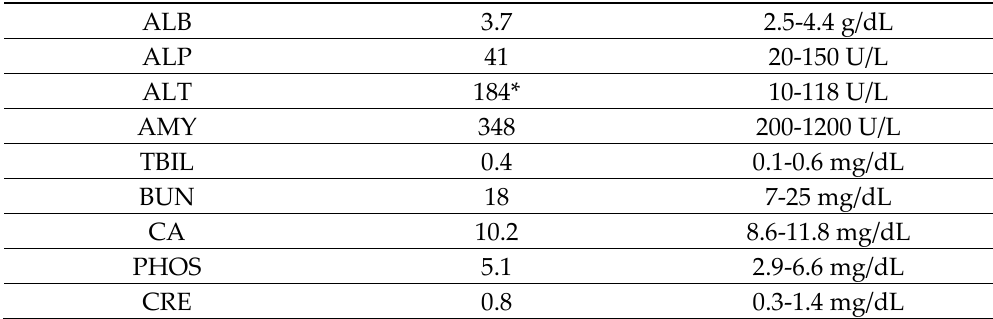
Table 1. Blood sample –